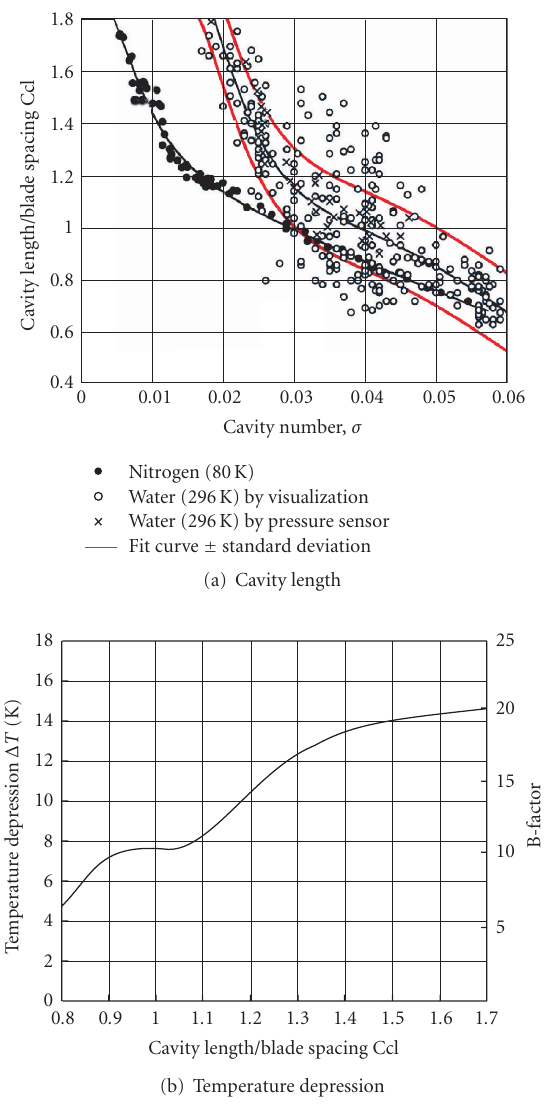
Figure 5: Experimental results in the case of LN2 and cold water (Yoshida et al. [1]).